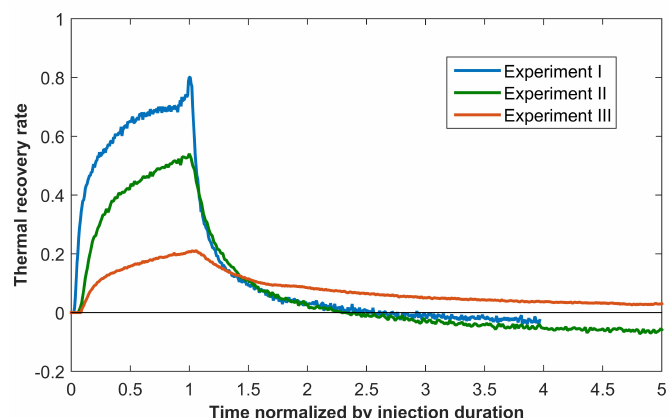
Figure 9. Thermal recovery rate for the di ff erent experiments as a function of the time normalized by the injection duration at B3-1A depth (34